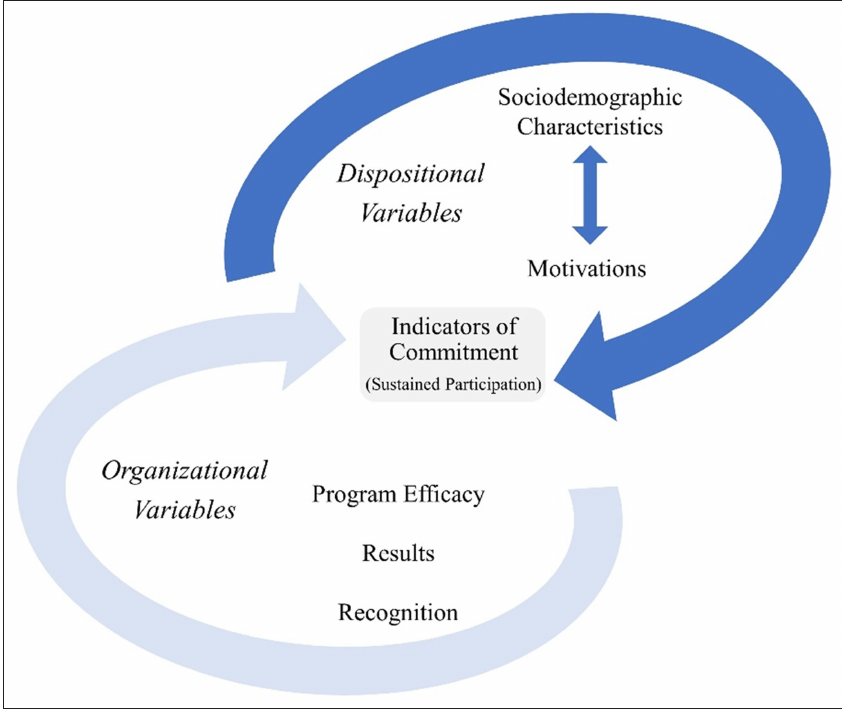
Figure 1 The Dispositional-Organizational Interactions Framework (DOIF), which demonstrates how dispositional variables, such as sociodemographic characteristics and motivations, are related to and may influence organizational variables, e.g., program efficacy, results, and recognition. These interactions may affect indicators of commitment, or sustained participation in CS